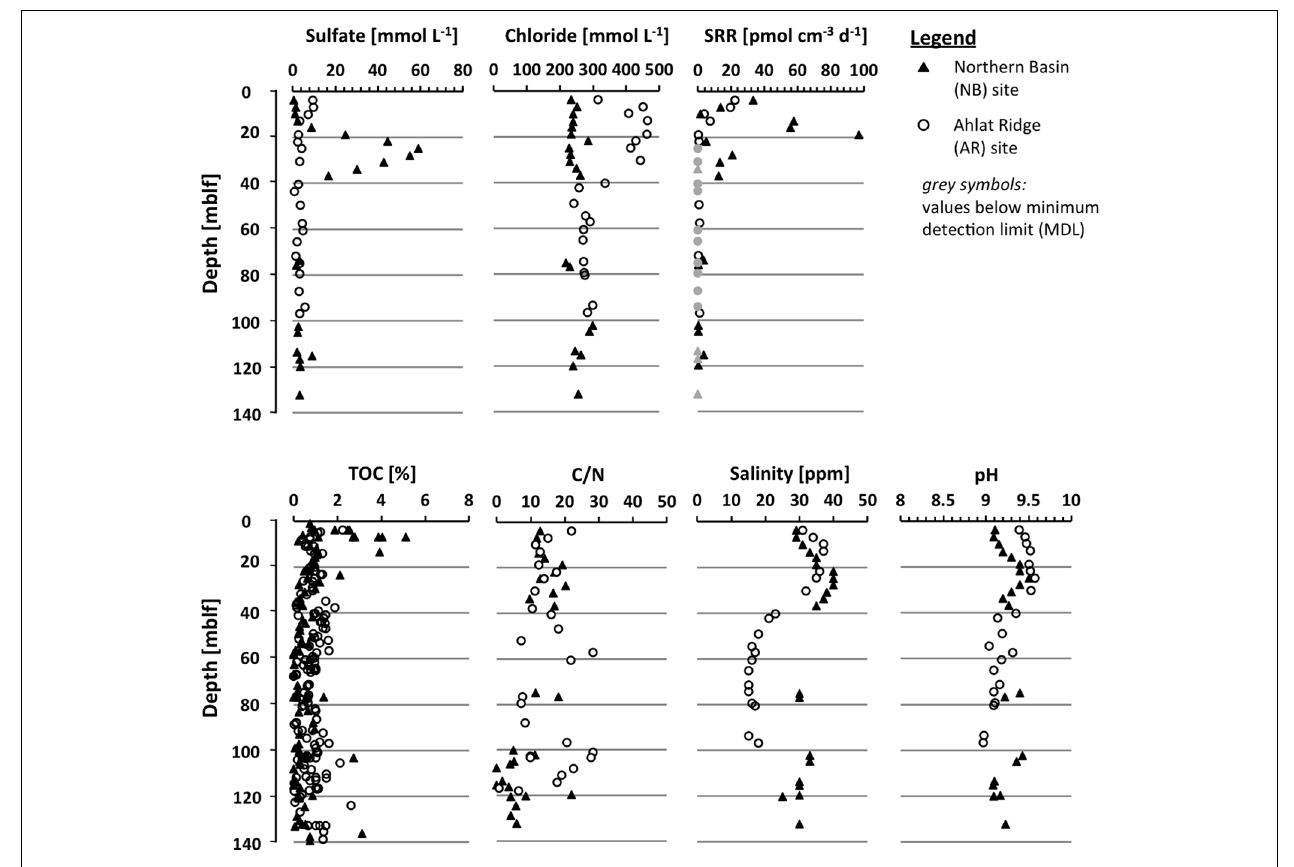
FIGURE 3 | Depth profiles of the drill cores (3.8–140 mblf) from the Northern Basin site (NB, black triangles) and theAhlat Ridge site (AR, open circles) for pore water concentration of chloride and sulfate, sulfate